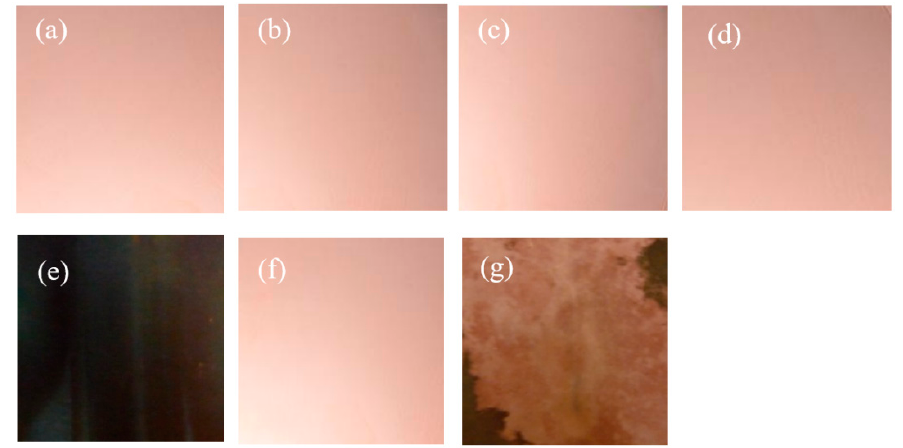
Figure 3. The original surface macro-morphology of the rolled copper foil ( a ) and its macro-morphology after corrosion in conditions B ( b ), C ( c ), D ( d ), E ( e ), F ( f ) and A ( g ).